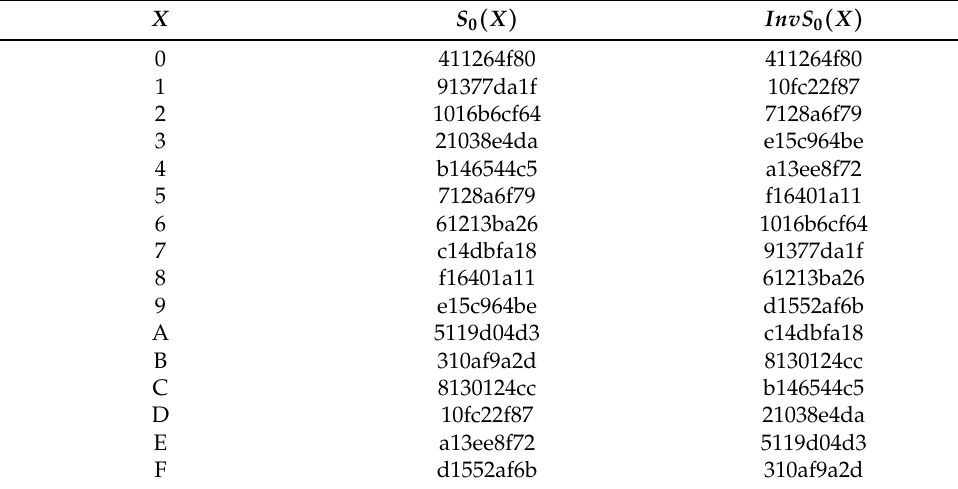
Table 10. New generated 32-bit output S-Box to replace Table 1.